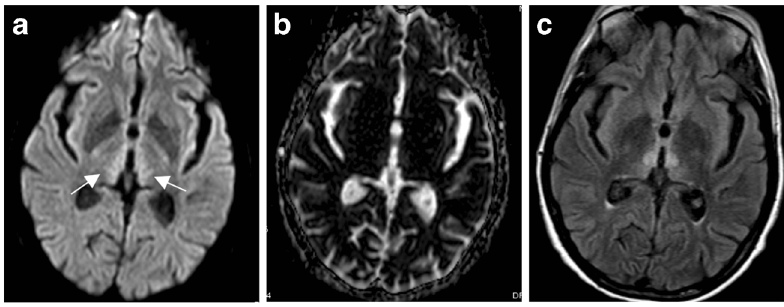
ADC ( b ) demonstrates subtle corresponding increased signal, suggesting increased diffusivity. FLAIR( c ) illustrates